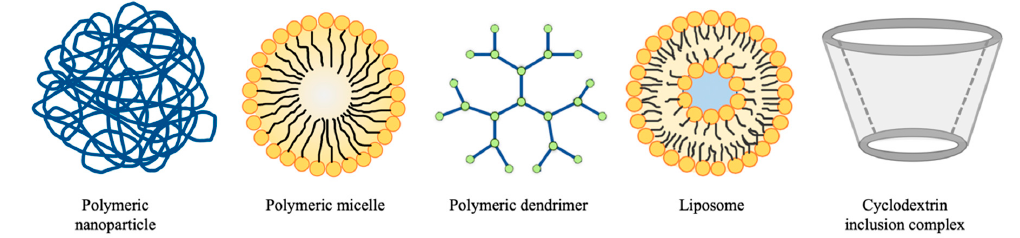
Figure 2. Various types of drug delivery systems (DDS) consisting of natural